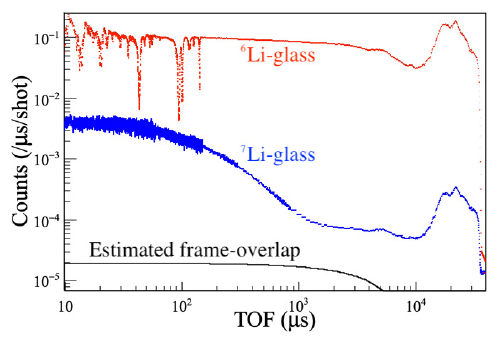
Figure 2. TOF spectra of the 6 Li- and 7 Li-glass detectors after dead-time correction and estimated frame-overlap backgrounds.